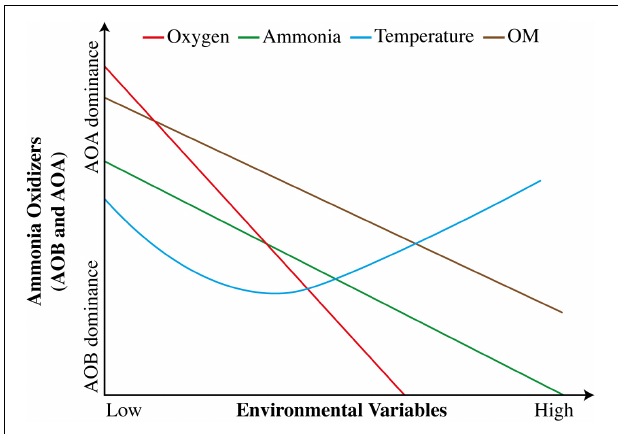
FIGURE 3 | Hypothetical variation in responses of AOA and AOB to changes in environmental factors (adapted from Ouyang et al., 2017).